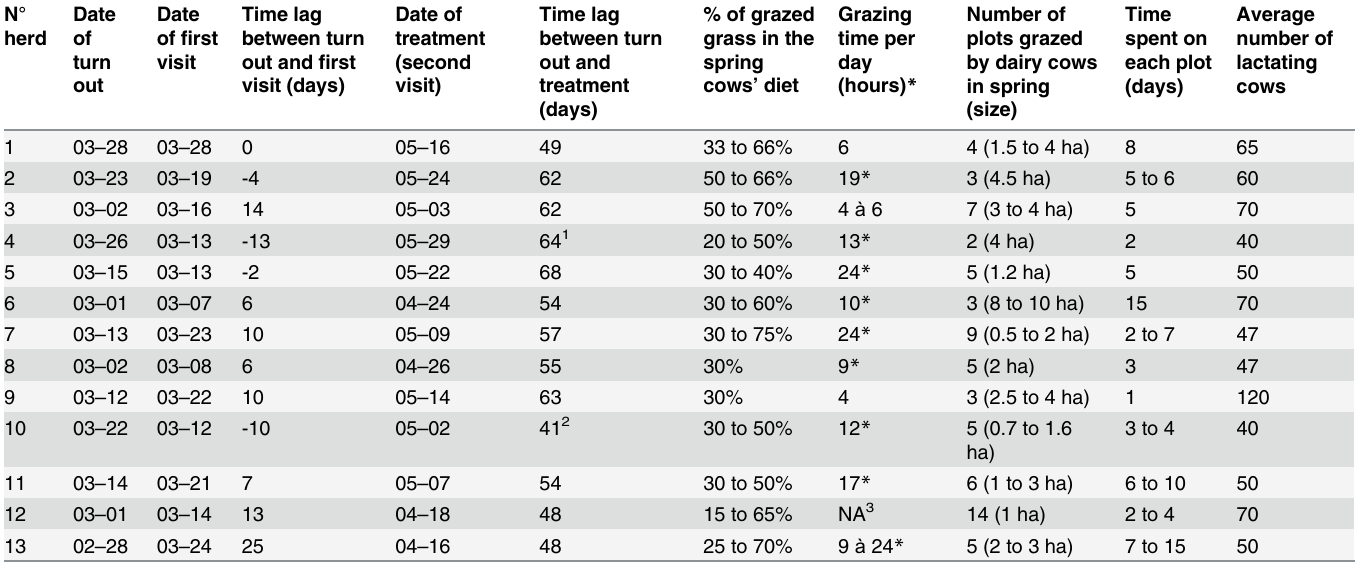
* In herds where the barn is always open (access to the automatic milking system, or access to feed in the trough), cows freely move from the barn to the pasture. The information given here is thus the duration of free access to pasture per day 1 In this herd, cows returned to the barn between 04 – 18 and 05 – 15, the actual time spent on pasture between turn out and treatment was thus 37 days. 2 In this herd, cows returned to the barn between 04 – 25 and 05 – 02, the actual time spent on pasture between turn out and treatment was thus 34 days. 3 NA = Not